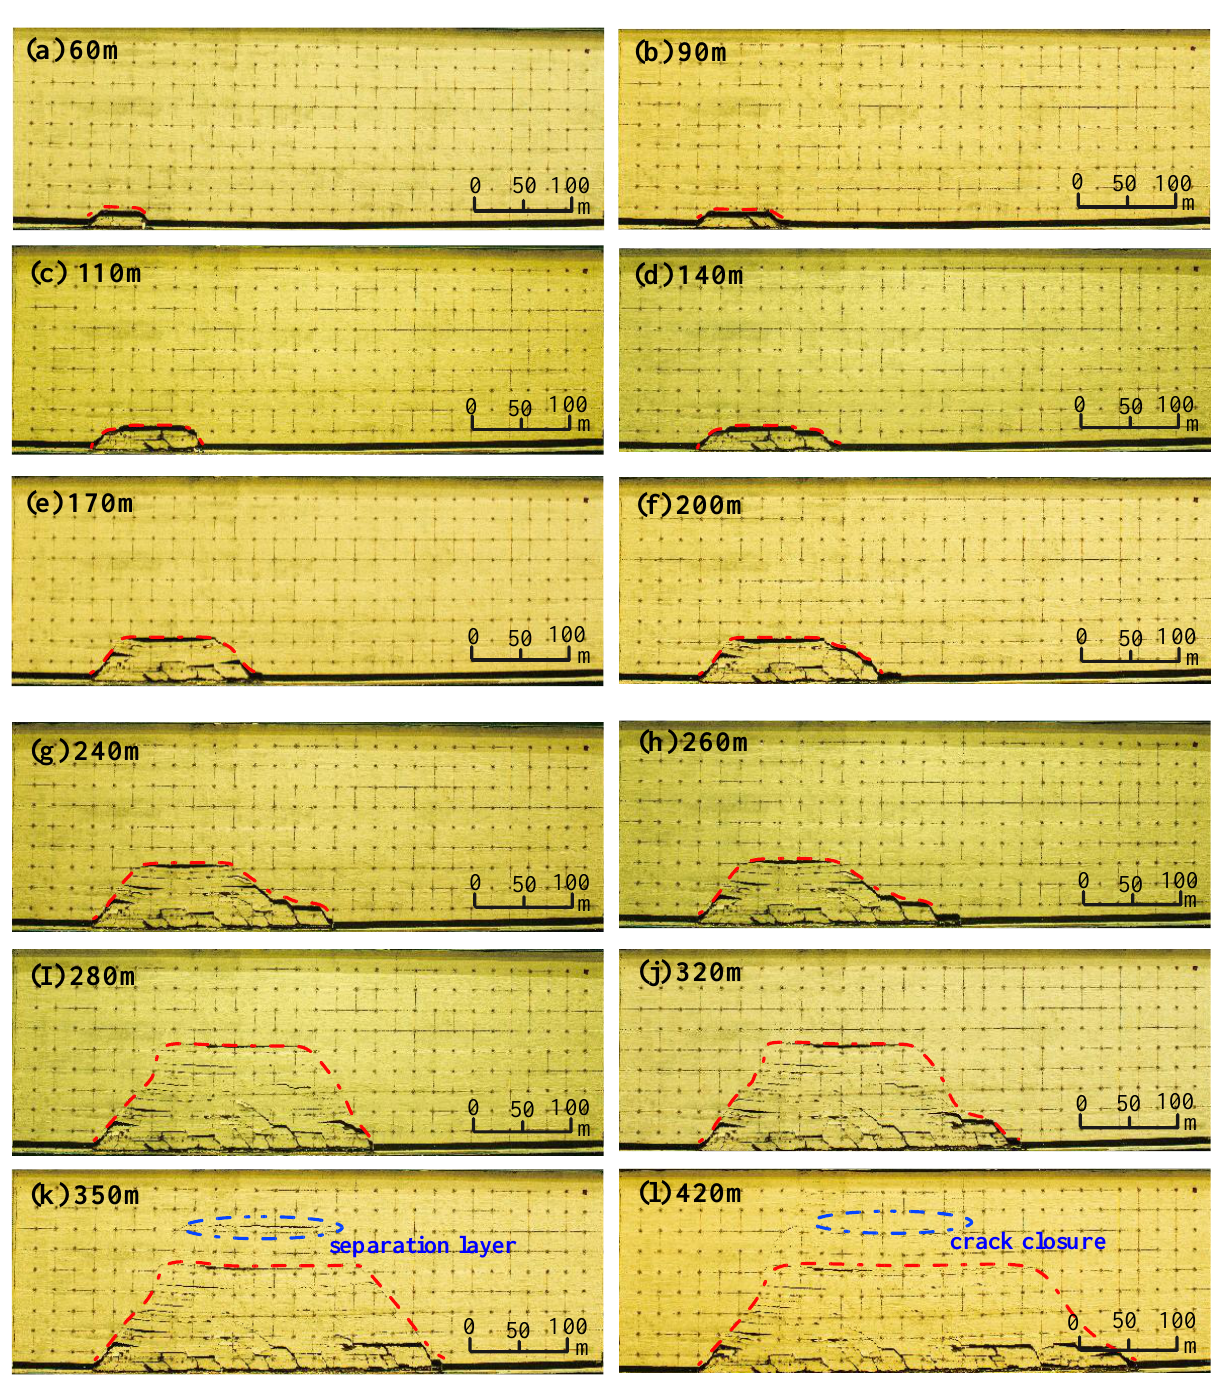
Figure 9. ( a – l ) describes the failure development of the overburdened strata and the evolution of the separation layer during from the initial mining period(60 m) to the completion of mining(420 m).